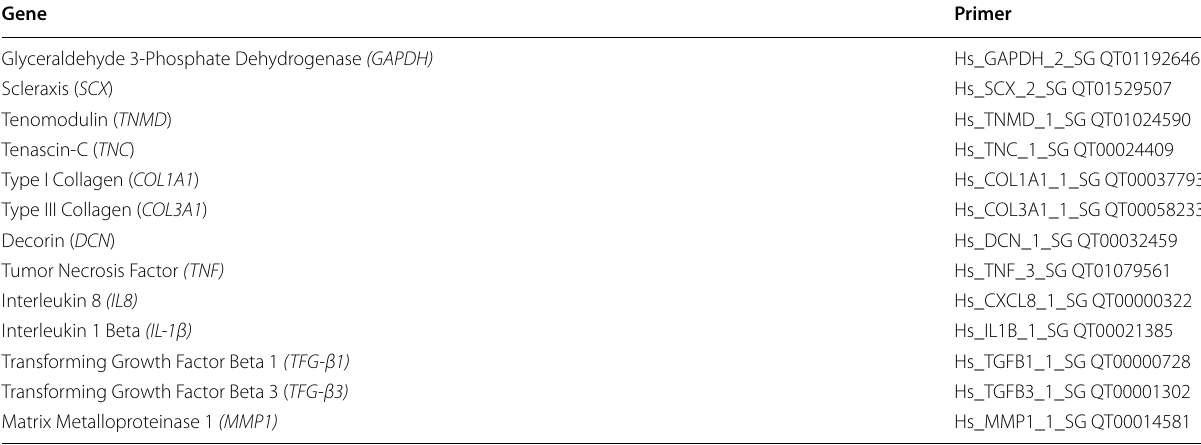
Table 2 Primers for quantitative polymerase chain reaction. The genes and primers for qPCR are listed Gene Primer Glyceraldehyde 3-Phosphate Dehydrogenase (GAPDH) Scleraxis ( SCX